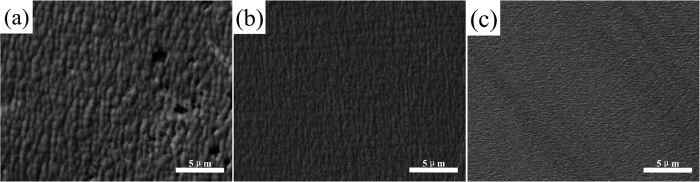
Surface morphology figures of the In0.82Ga0.18As layer obtained at different growth temperatures: (a) 430 °C; (b) 410 °C; (c) 390 °C.